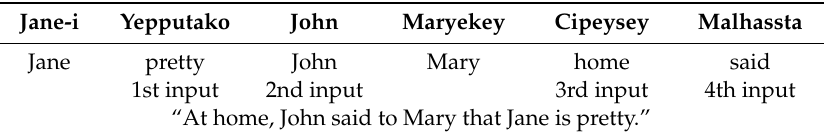
Table 1. An example of input data.